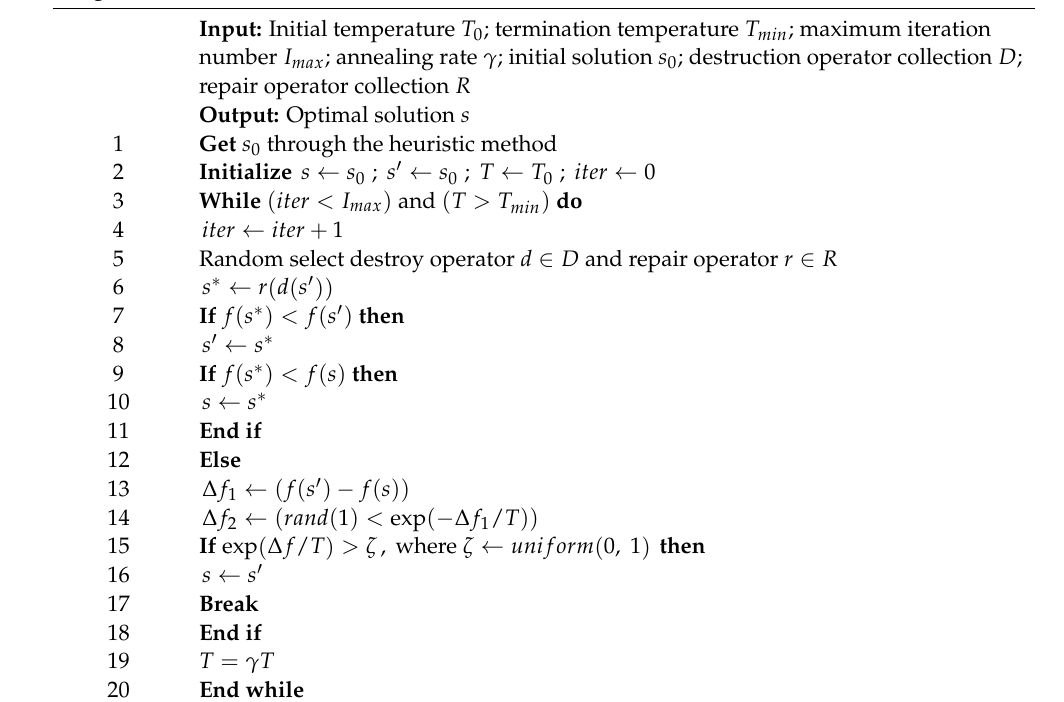
Algorithm 1: Framework of